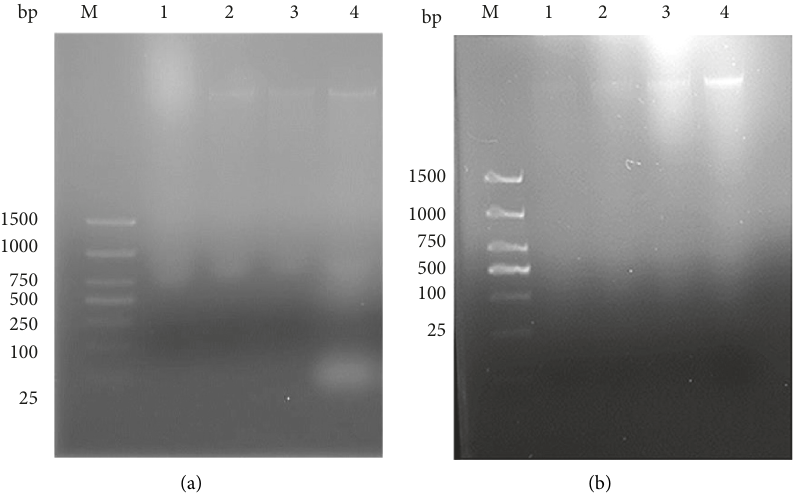
Figure 2: Activity tests and tagmentation demonstrated with the Tn5 transposase. (a) M: Marker; line 1–3: several reactions were performed simultaneously with different dilutions of Tn5 ranging from 1.25ng/ml, 2.5ng/ml, and 5 ng/ml; line 4: control group. (b) DNA sample digested by Tn5 transposase. M Marker; line 1–3: the volume of Tn5 enzyme added in different reactions was 8 µ control